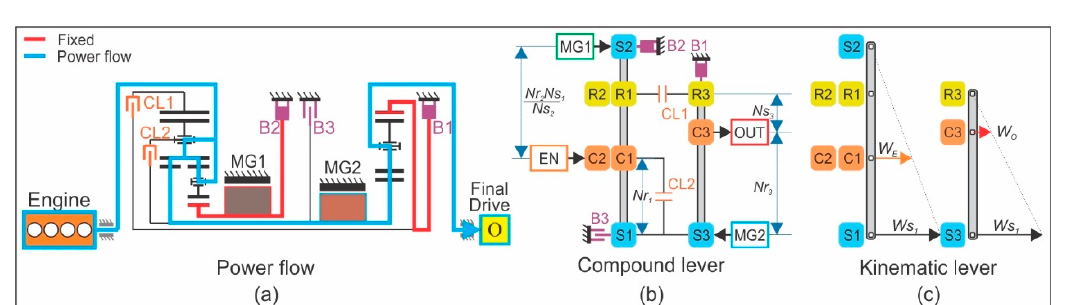
Figure 22. Third fixed gear. 10.4.4. 4th Fixed Gear With (cid:1849) (cid:2929)(cid:2869) = (cid:1849) (cid:2929)(cid:2871) = (cid:1849) (cid:2870) , (cid:1849) (cid:2928)(cid:2869) = (cid:1849) (cid:2928)(cid:2871) , (cid:1849) (cid:2929)(cid:2870) = (cid:1849) (cid:2869) = 0 , (cid:1849) (cid:2899) = ((cid:1863) (cid:2870) − 1)(1 + (cid:1863) (cid:2871) ) + 1 + (cid:1863) (cid:2869) (cid:1863) (cid:2870) (1 + (cid:1863) (cid:2871) )